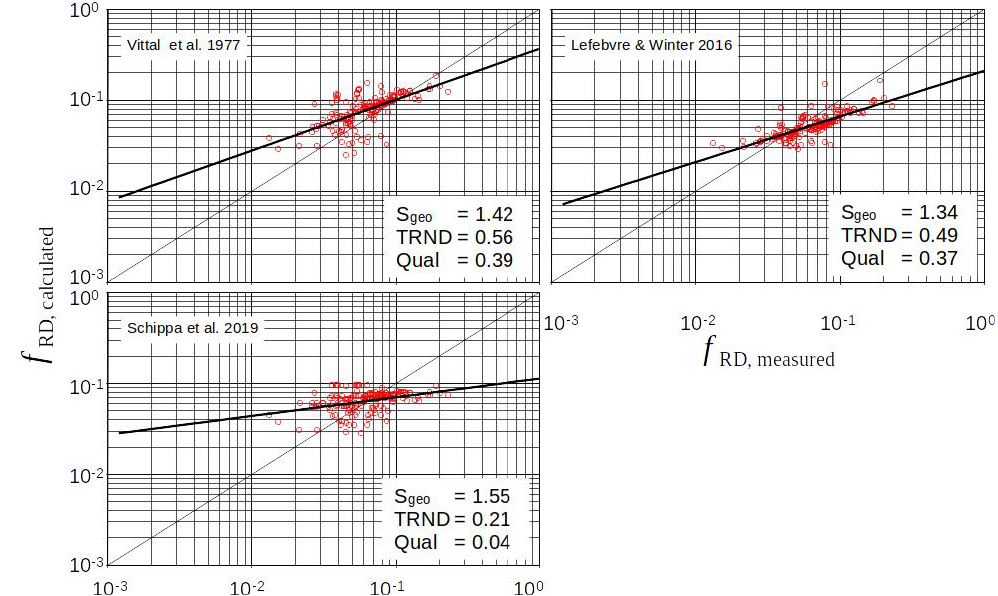
Figure 7. Purely ore widely empirical approaches in the case of